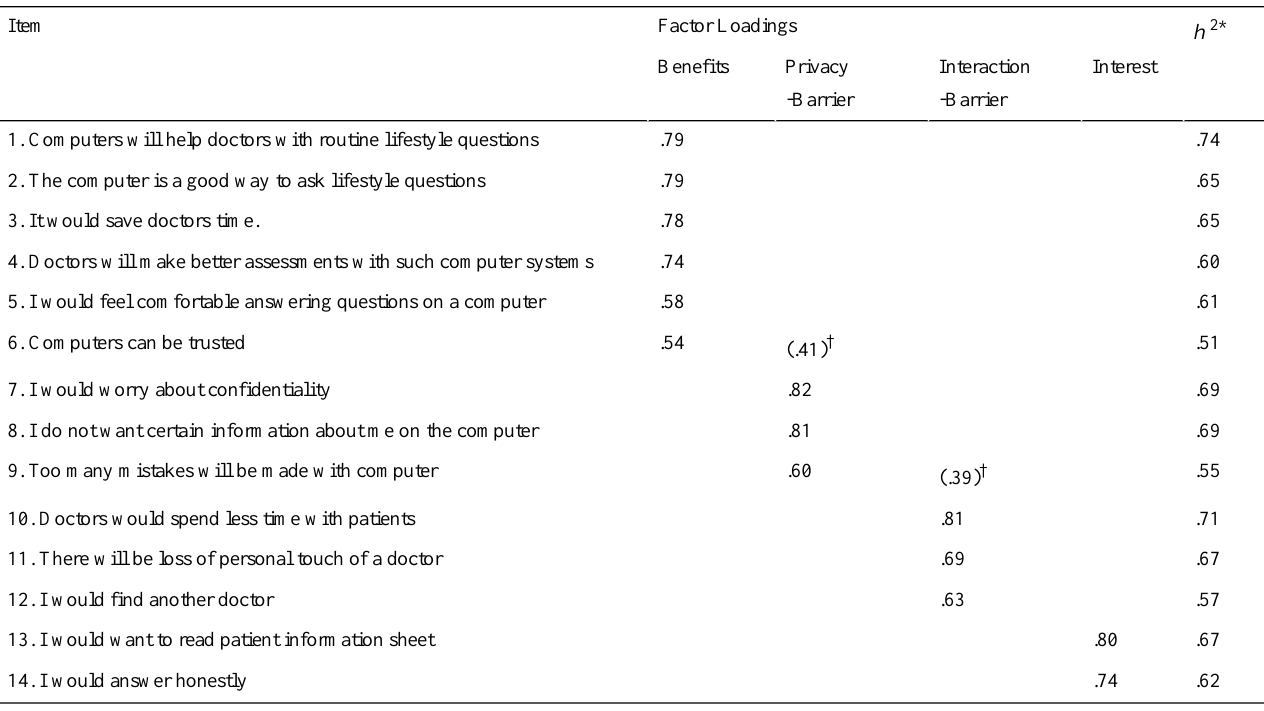
Table 3. Summary of principal component analysis with varimax